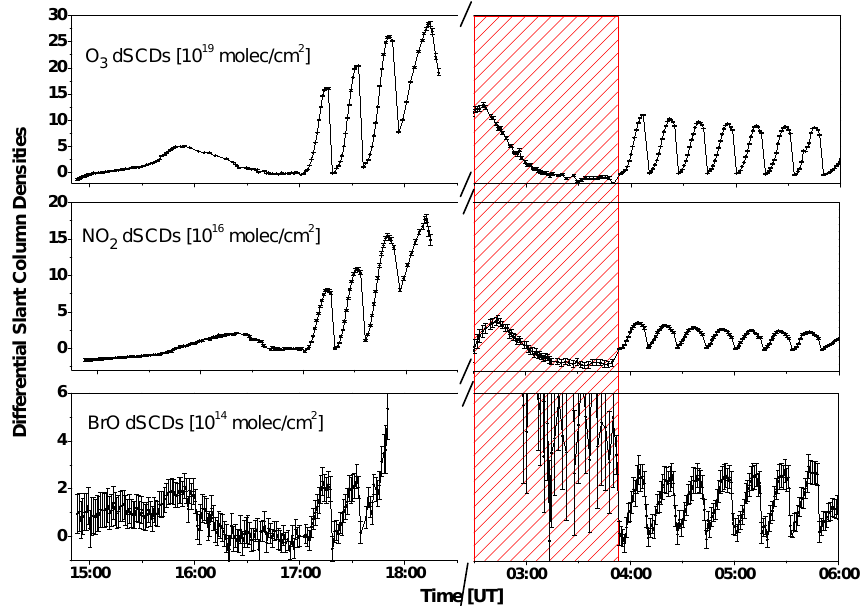
Fig. 1. Measured differential slant column densities of O 3 (upper panel), NO 2 (middle panel), and BrO (lower panel) in limb geometry during the balloon flight from Kiruna on 7 and 8 September 2009. During balloon ascent from 14:50UT until 17:10UT, the limb radiation was observed for an elevation angle of 0 . 05 ◦ . During dusk (17:10 to 18:30UT), 3.5limb scans were performed at 33km altitude. During early dawn, the scanning telescope of the limb spectrometer malfunctioned (the reddish area), and the limb scans (in total 7.25) started at 03:50UT and continued until 06:00UT, when the balloon was floating at 31km altitude. Each limb scan consists of limb observations from + 0 . 6 ◦ elevation angle down to − 4 . 88 ◦ in steps of 0 . 39 ◦